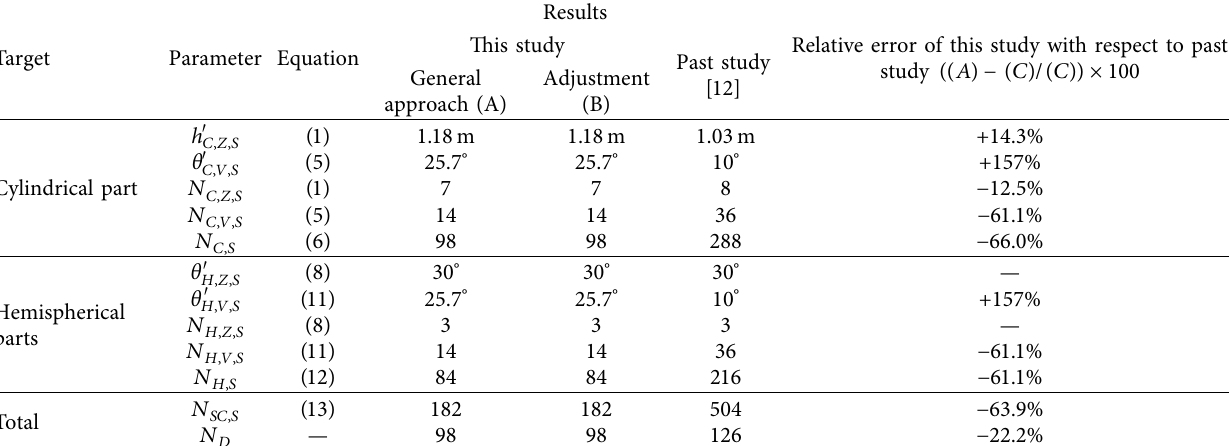
Table 4: Comparison of segmentation strategies derived in this study and reported in the past study for the same target object and container defined in Table